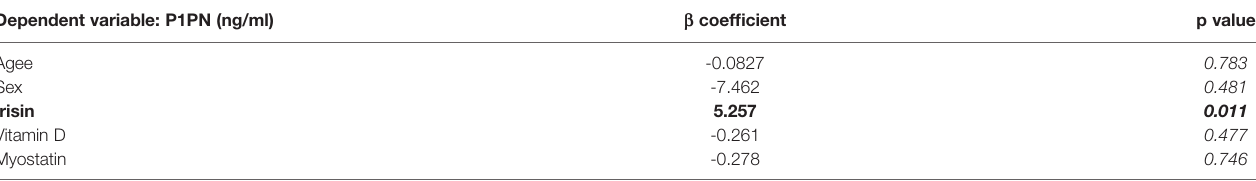
The bold values are statistically signi fi cant.